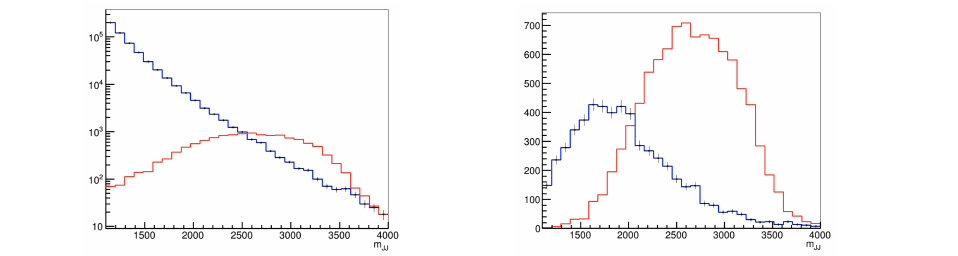
Figure 6. G RS → t ¯ t broad benchmark with σ = 10pb: Dijet mass spectrum before VAE cut (left) and dijet mass spectrum after VAE cut